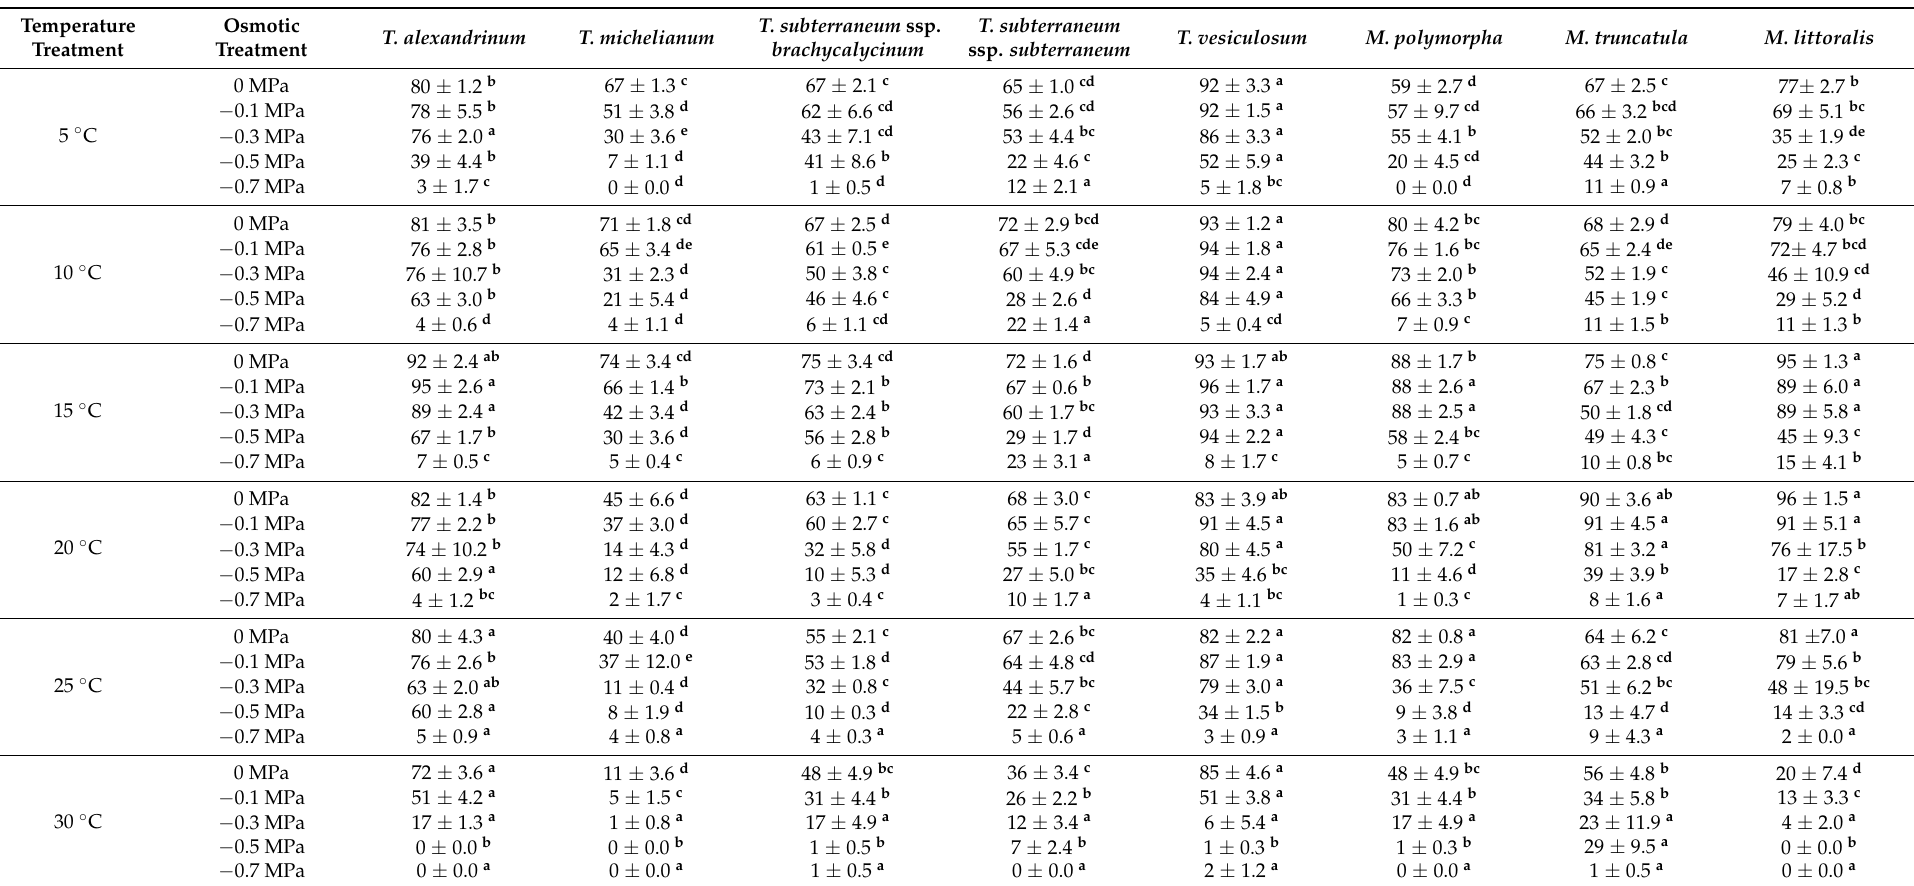
Table 2. Differences in seed germination potential (mean % ± SEM) between three annual Medicago and five annual Trifolium species under different germination temperatures and osmotic treatments. Different letters indicate significant differences ( p < 0.05) in germination between the different species. Comparisons were made within each osmotic treatment within a